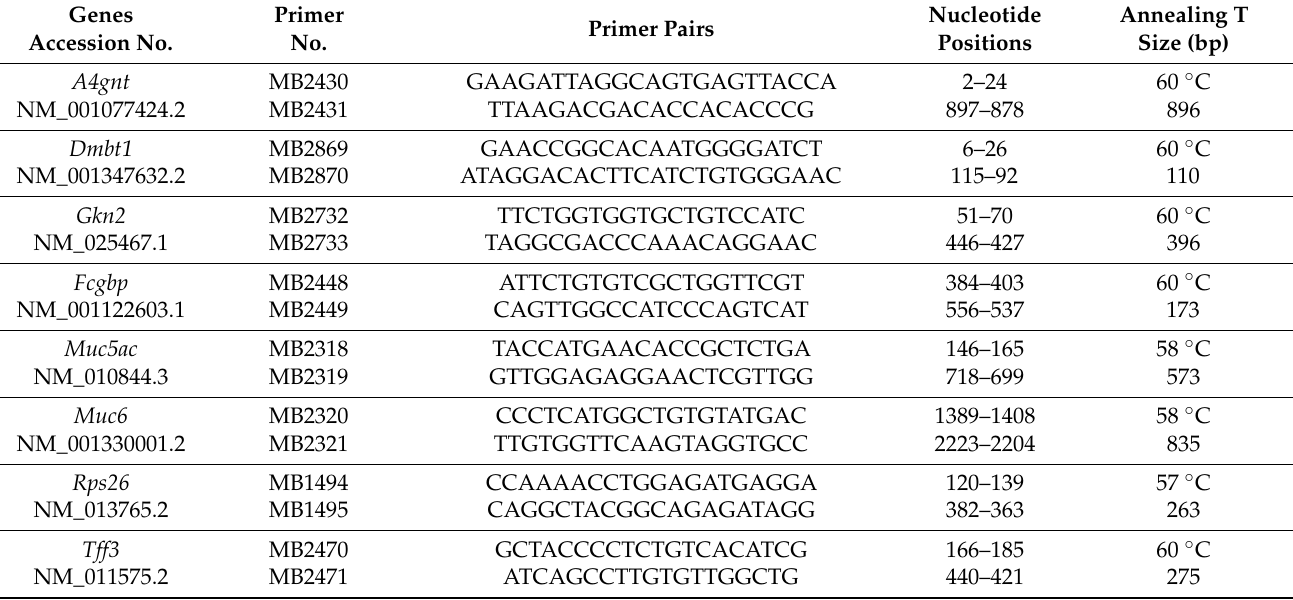
Table 1. Oligonucleotides used for RT-PCR analysis and calculated size of the